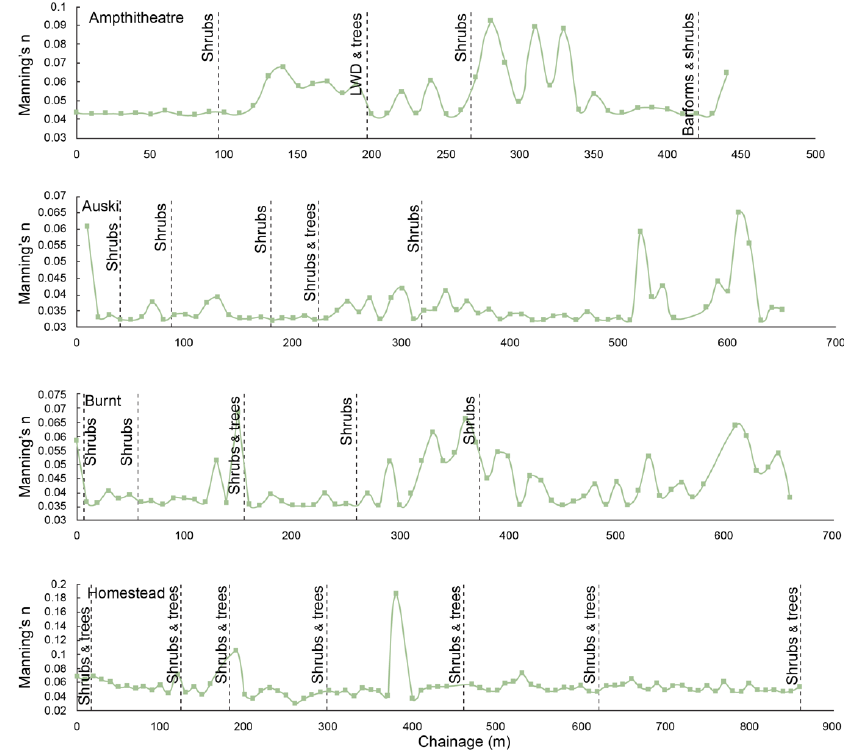
Remote Sens. 2022 , 14 , 454 Figure 9. Longitudinal variations in channel roughness for selected channels. Figure 9. Longitudinal variations in channel roughness for selected channels.